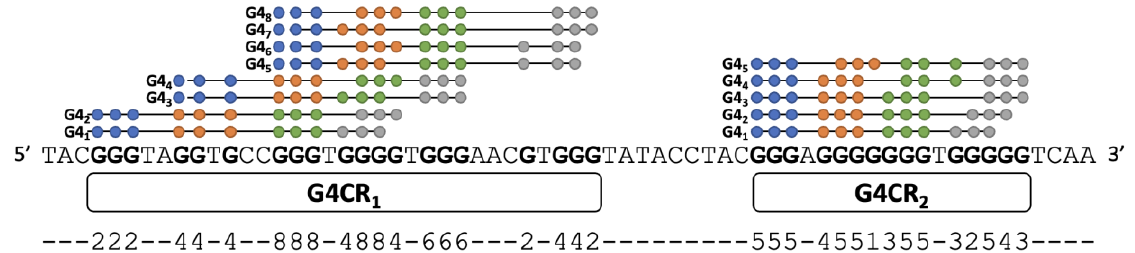
Figure 3. Hypothetical stretch of DNA containing two G4CRs. Filled circles above the sequence indicate the core G residues in each possible isomer. The multiplicity of each G residue is indicated at the bottom of the figure.